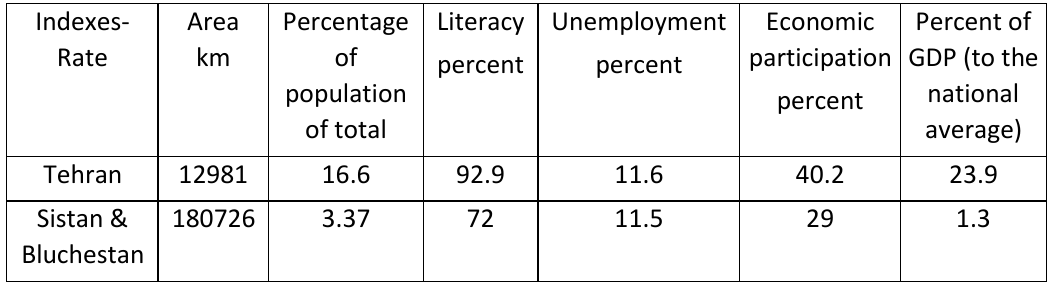
Table 2: Socio-economic data of Tehran and Sistan & Baluchestan